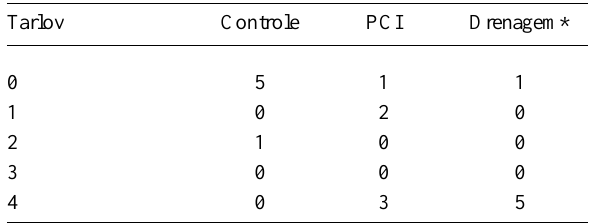
Na avaliação do PESS, estudamos o tempo de